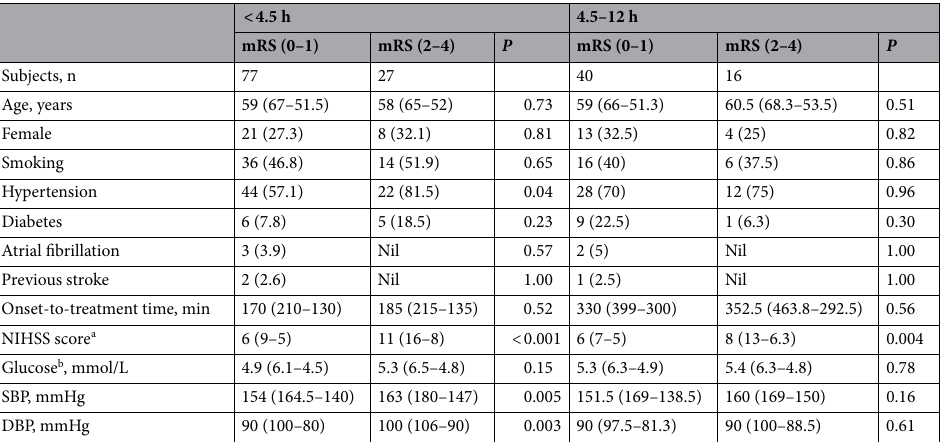
Table 4. Baseline and clinical characteristics of patients with LSA stroke between IV-TPA within 4.5-h and 4.5–12 h and subdivided by outcomes. Reported as n (%) or median (IQR = Q3–Q1), or as indicated. a Baseline.